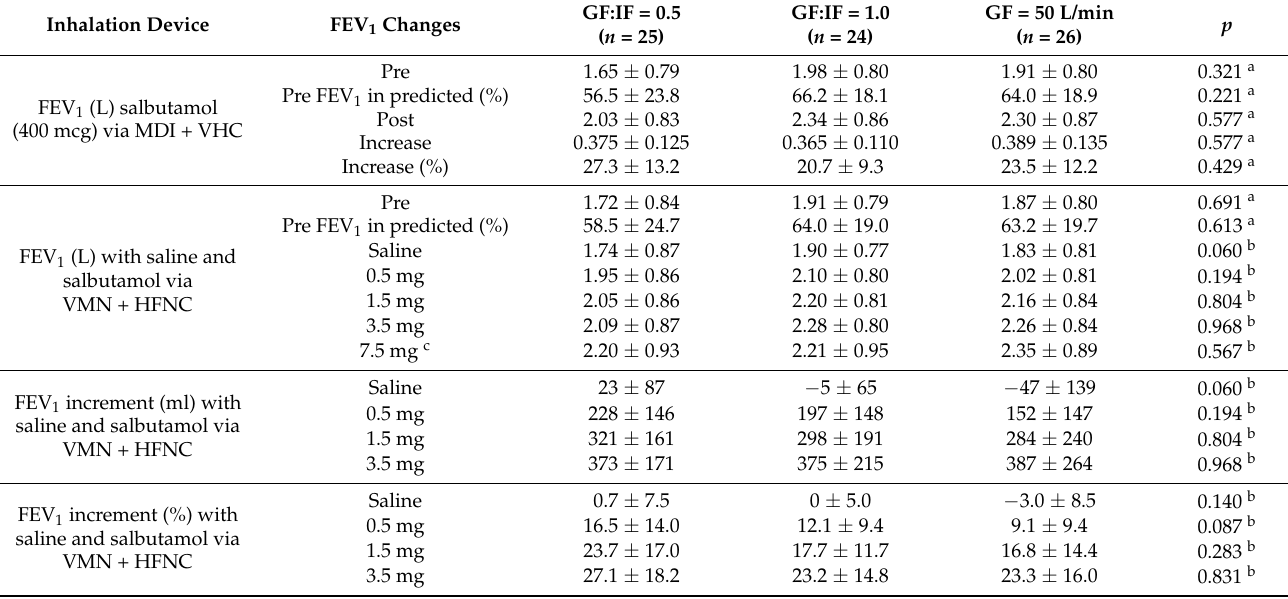
Table 3. The changes of FEV 1 after inhaling salbutamol via MDI with VHC and after inhaling saline and salbutamol at different doses via